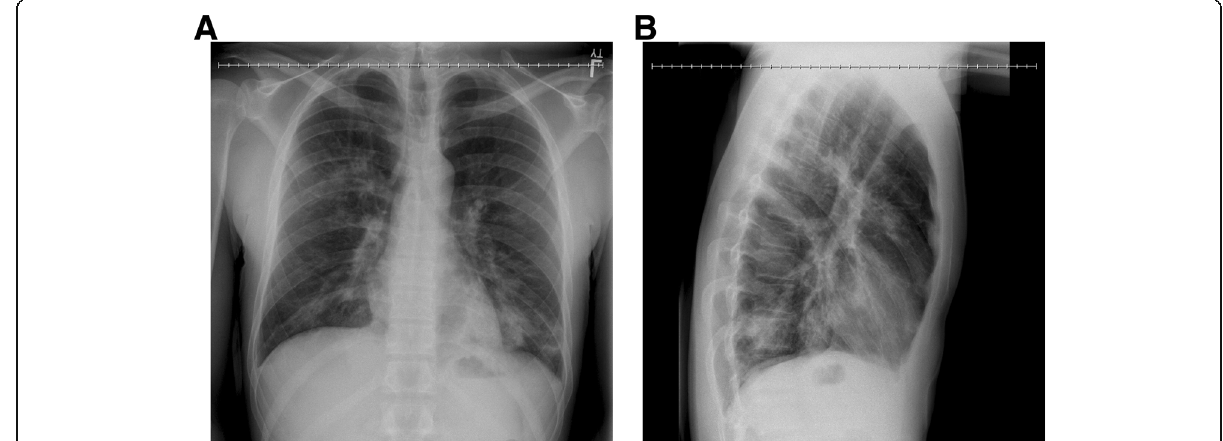
Fig. 1 Chest x-ray on admission; PA and lateral view. Patchy infiltrates can be seen in both lower lobes and the right upper lobe